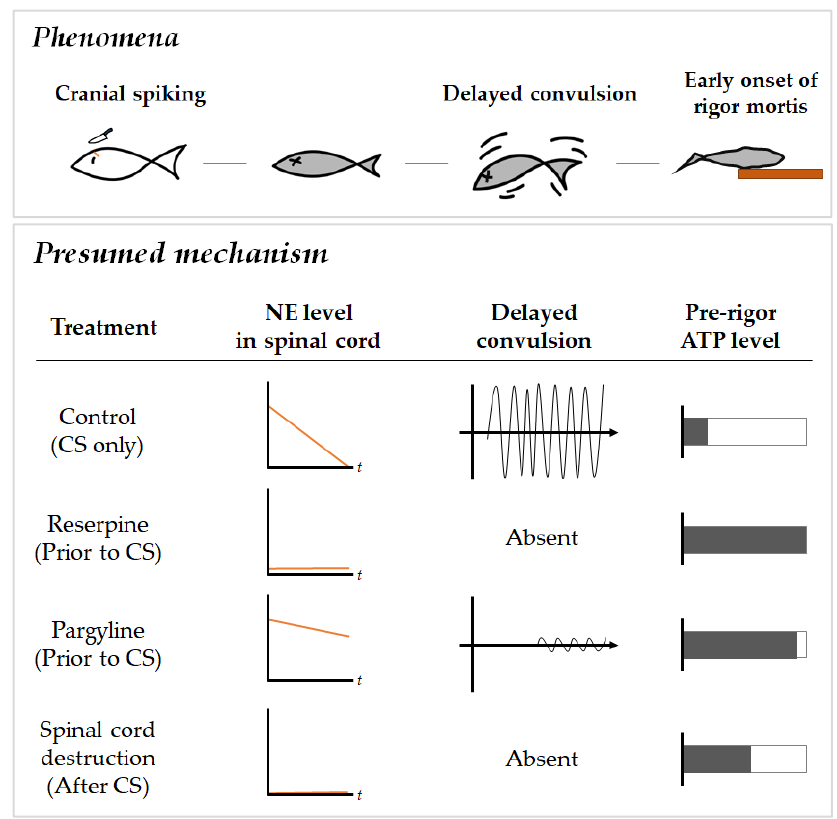
Figure 1. Diagram of delayed convulsion phenomenon and proposed mechanism [20]. Rate of NE depletion plays an important role in the delayed convulsion pattern which affects the pre-rigor ATP levels